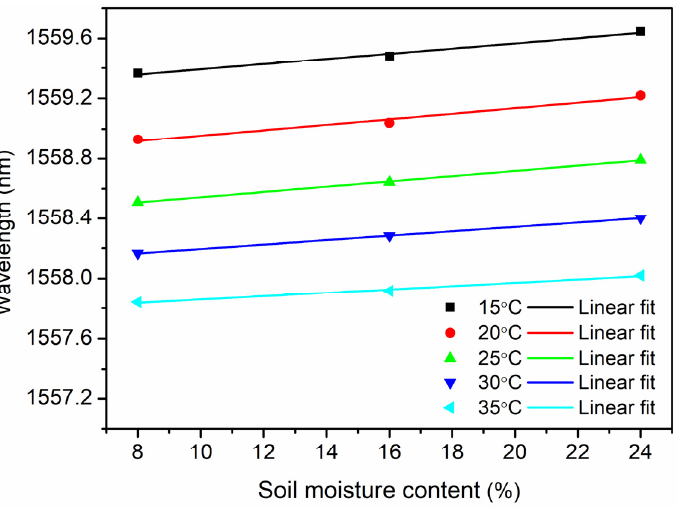
Figure 8. Linear fit of Bragg wavelength versus SMC from 8% to 24% at a constant temperature from 15 °C to 35 °C with a step of 5 °C.